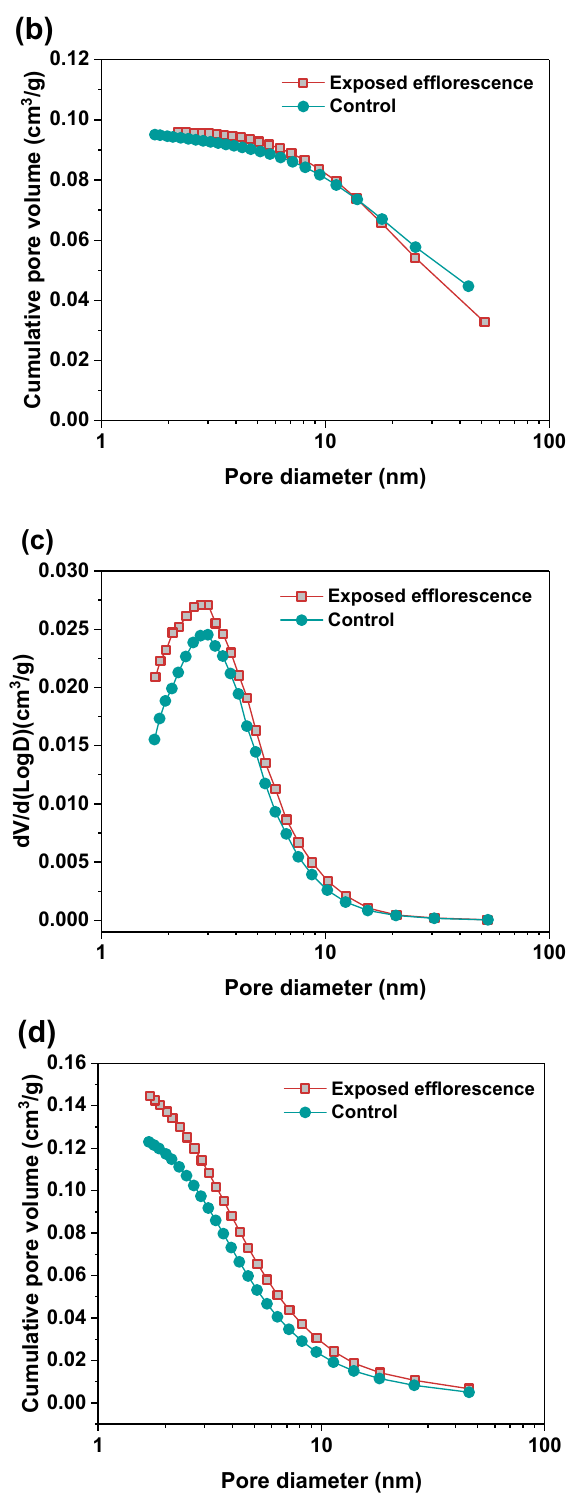
Figure 9. Pore size and cumulative pore volume distribution curves of control and exposed ( a , b ) NHFS and ( c , d ) NSFS samples. Table 2. Pore structure parameters of the control and exposed geopolymers.